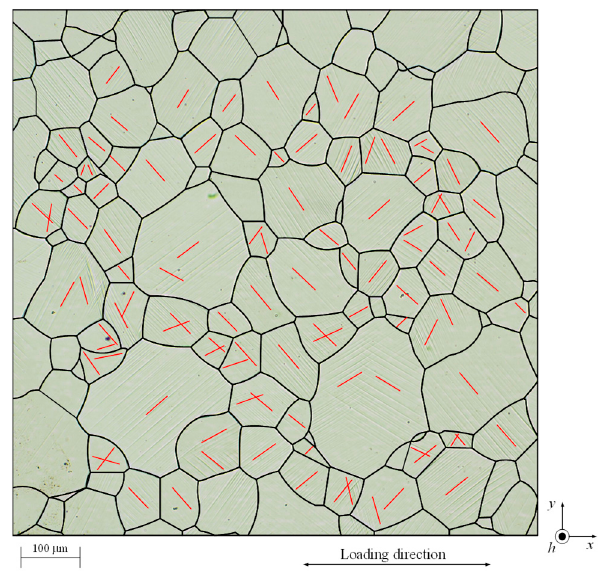
Figure 7. Slip-line directions in each grain.